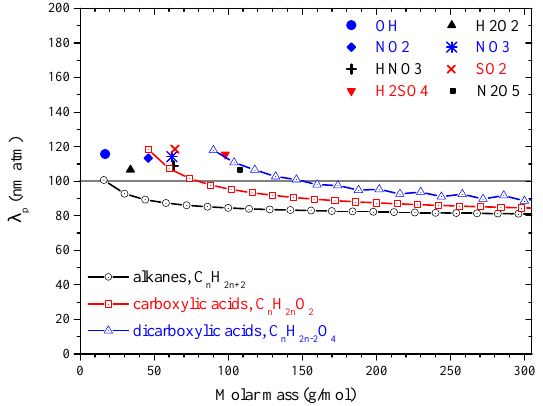
Figure 2. Knudsen numbers ( Kn ) for the uptake of four organic compounds (glyoxal, MVK, C 10 H 16 O 5 , C 20 H 32 O 12 ) and four in- organic compounds (OH, NO 2 , NO 3 , and N 2 O 5 ) onto aerosol par- ticles as a function of particle diameter in 760Torr air. Knudsen numbers calculated using the empirical equation (Eq. 11) we pro- pose in this work are also plotted.